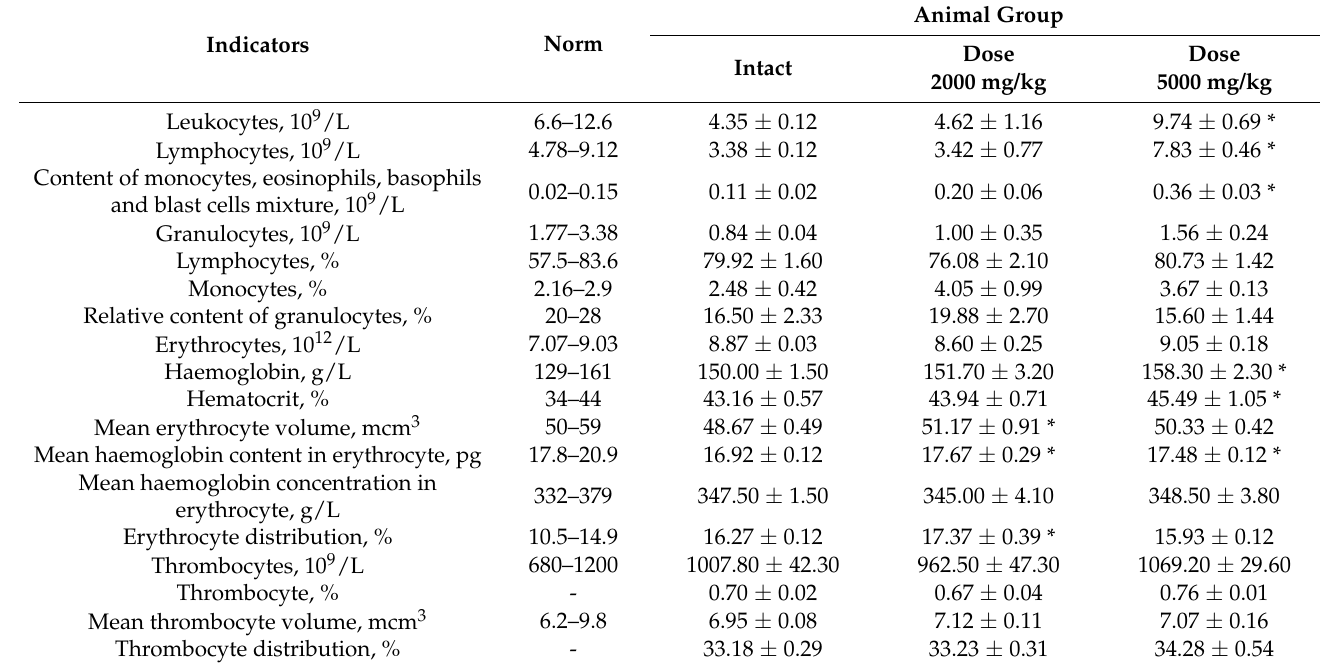
Table 4. Haematology test panel for animals’ blood after acute toxicity test two weeks after the administration of D. deltoidea cell biomass.